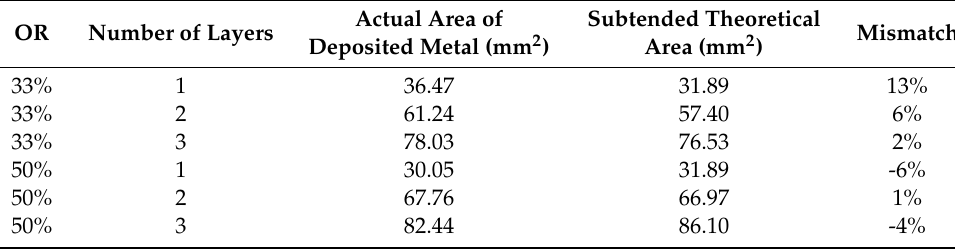
Table 7. Comparison between actual and theoretical area of the deposited metal for given OR in multi-layer deposition.